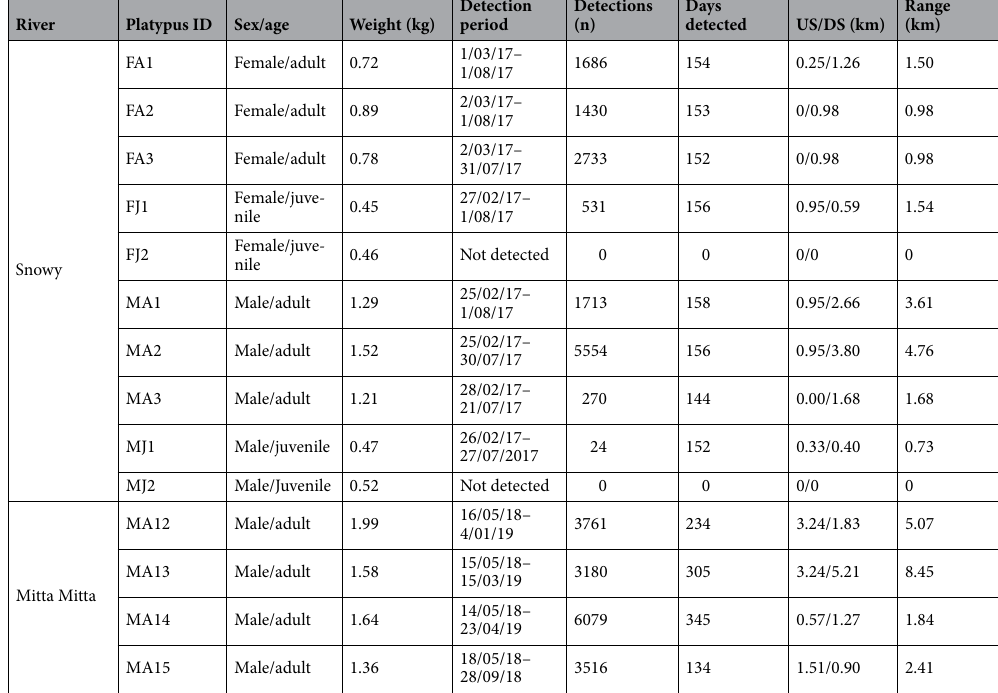
Table 1. Identifications, weight (kg), detection dates, number of detections, maximum upstream (US) and downstream (DS) detection (km) from initial tagging location, and linear river range (km) for individual platypuses with transmitters on the Snowy River (Feb–Aug 2017) and Mitta Mitta River (May 2018–Apr